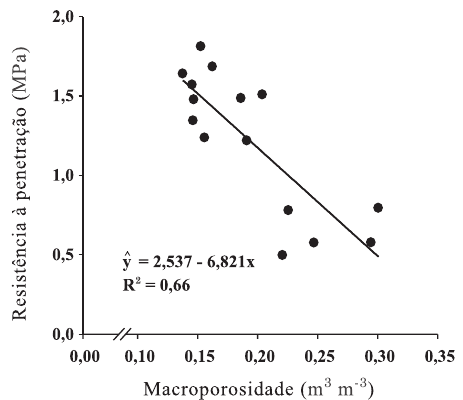
Figura 7. relação entre macroporosidade